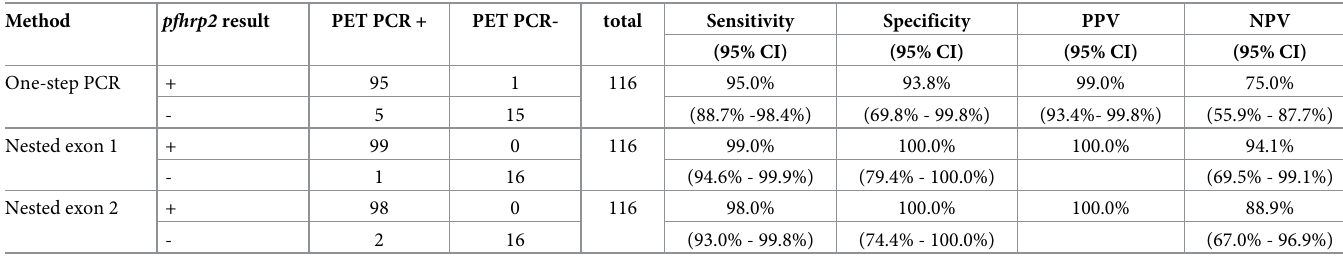
Table 3. Sensitivity, specificity, positive predictive value and negative predictive value of pfhrp2 detecting PCR methods compared to PET PCR.